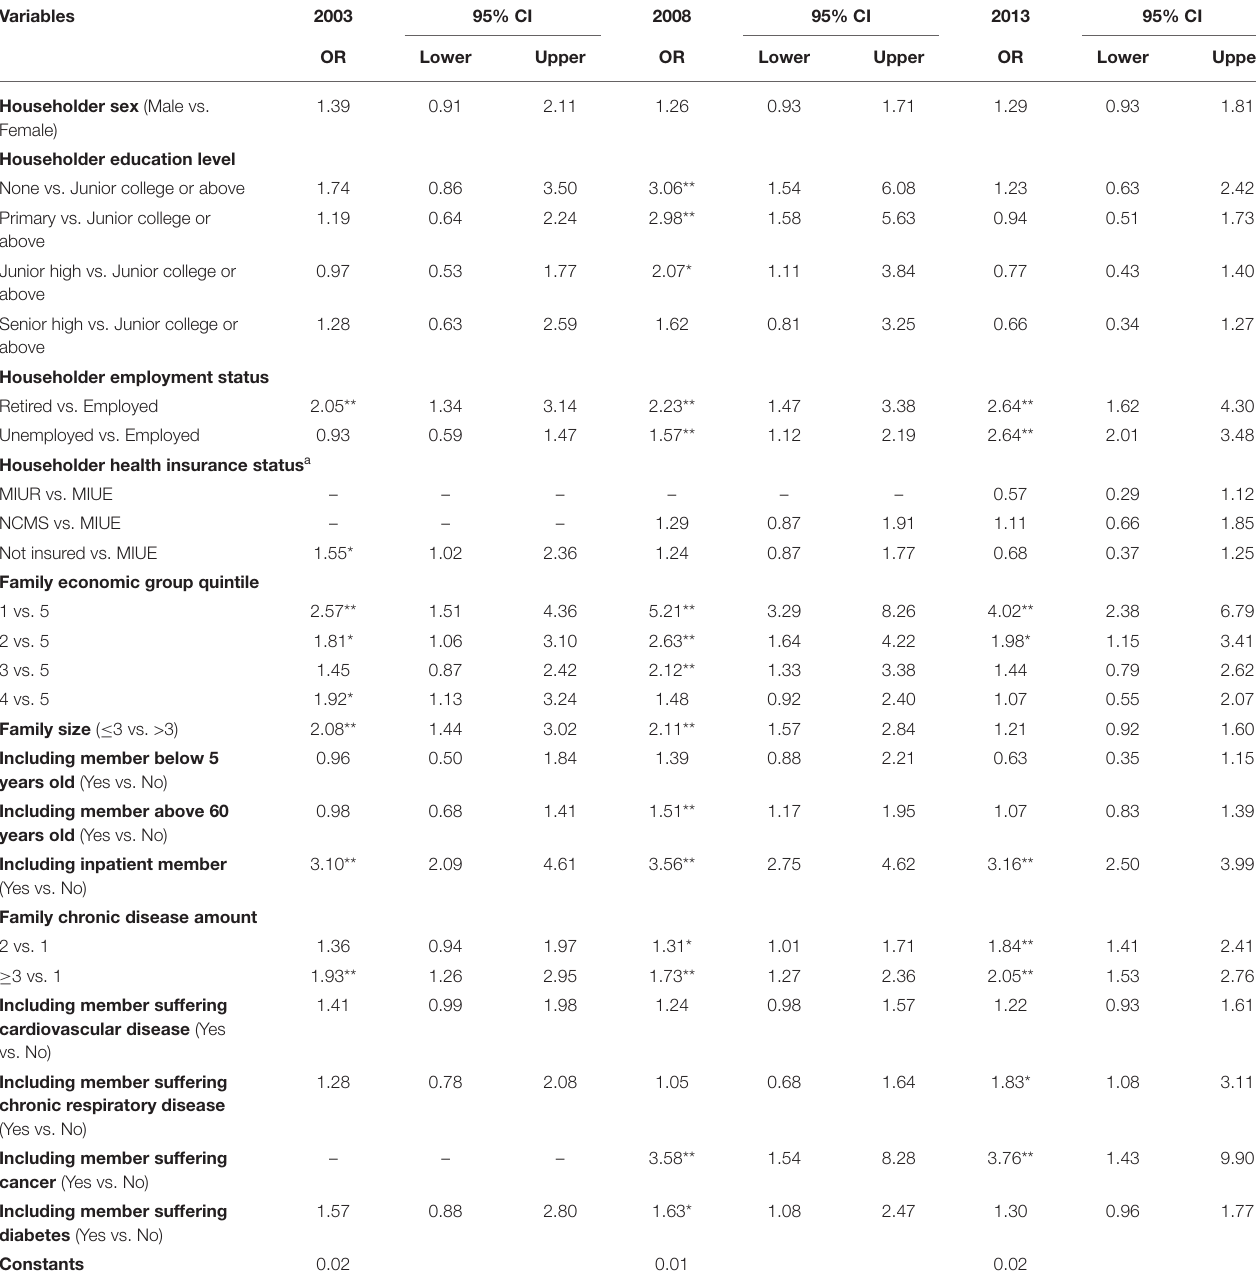
TABLE 5 | Determinants of catastrophic health expenditure for NCD households. Variables 2003 95% CI 2008 95% CI 2013 95% CI OR Lower Upper OR Lower Upper OR Lower